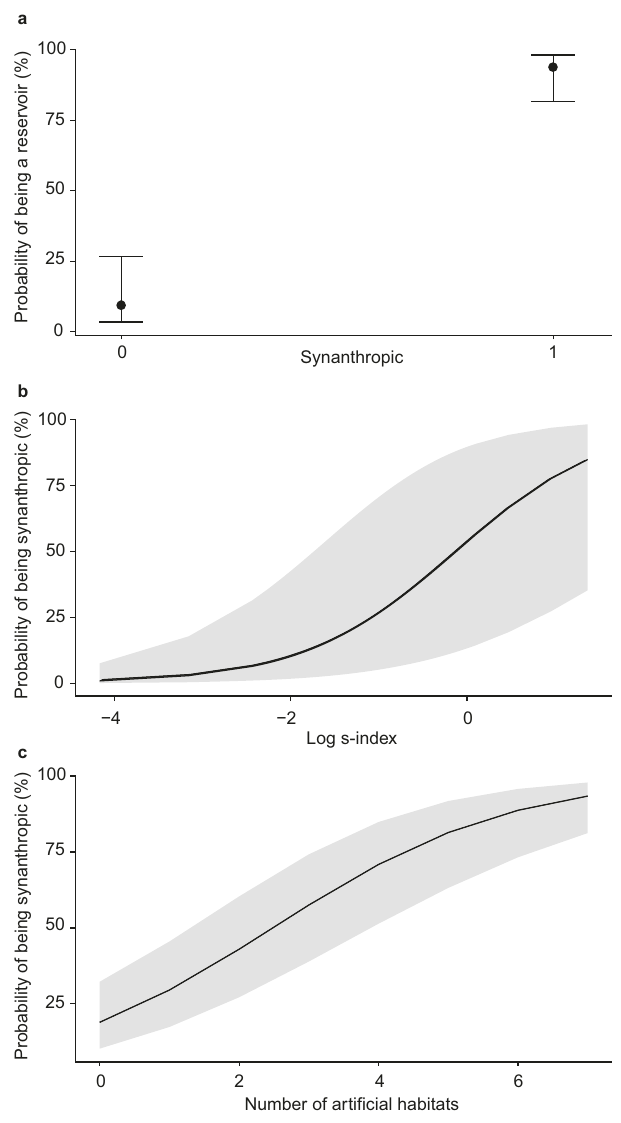
Fig. 3 | Characteristics of reservoir and synanthropic rodents. a Reservoir rodents are predominately synanthropic ( n =436 with n (non-reservoir) = 154, n (reservoir) = 282). b Synanthropic rodents display high population fl uctuations (high s-index) ( n =269) and c , occur in multiple arti fi cial habitats ( n =269) (Tables 1 – 3). In a , estimated probability and 95% con fi dence intervals are shown and in b – c , estimated probabilityisshownand shaded areasshow 95% con fi dence intervals.